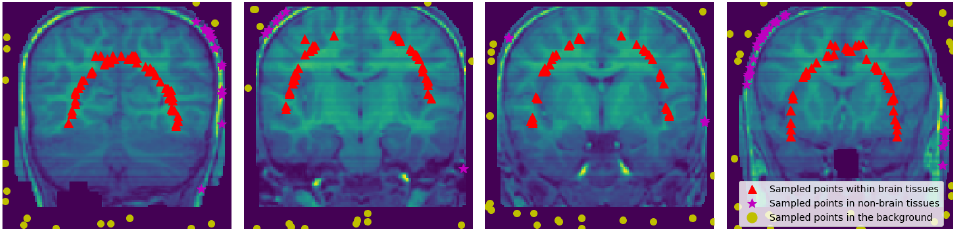
Figure 5. Sampled Points: 2D visualization of the representative coronal section from MRI image of a single subject (IBSR data) showing the sampled points within the brain region, within non-brain tissues, and in the background. δ 1 and δ 2 values were set to 15 and 3, respectively. Notice the removed part of the skull and the brain from some